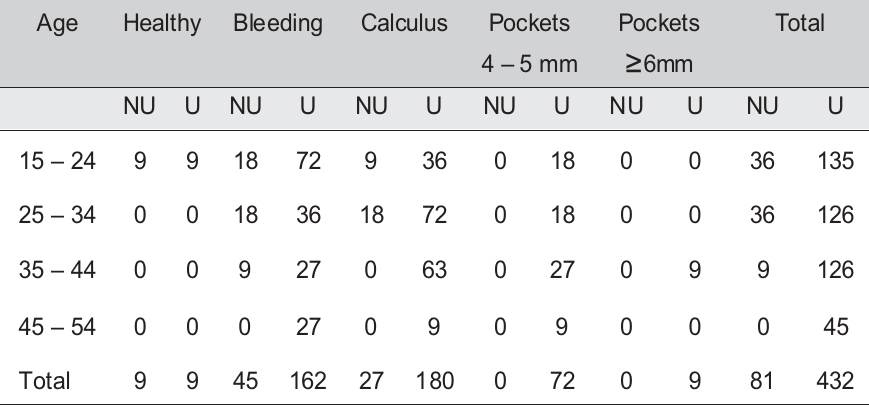
Table 2 - Distribution of Tobacco Users (U) and Non – Users (NU) in accordance with CPI scores in different age groups